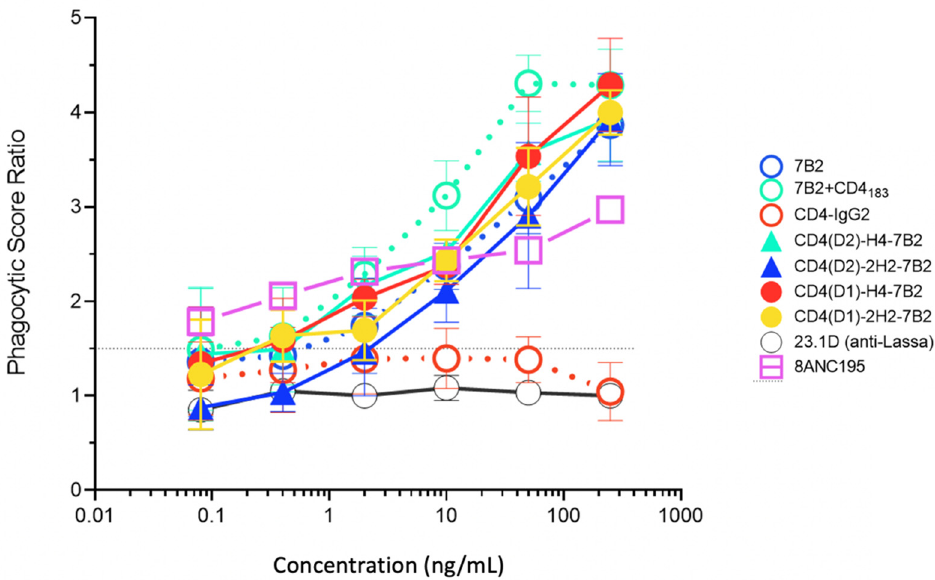
Figure 6. Antibody-dependent phagocytosis with panel mAbs and Ig-adhesins. We quantified the ingestion of gp140-coated fluorescent beads by THP-1 cells. Beads were opsonized with the indicated Ab. The novel Ig-adhesins are represented as solid lines and symbols, while the controls are dotted lines and open symbols. For each concentration, the phagocytic score and SEM are shown. When no error bars are visible, they are smaller than the symbol. The horizontal line indicates the cutoff for significance. The data shown are representative of three separate experiments.